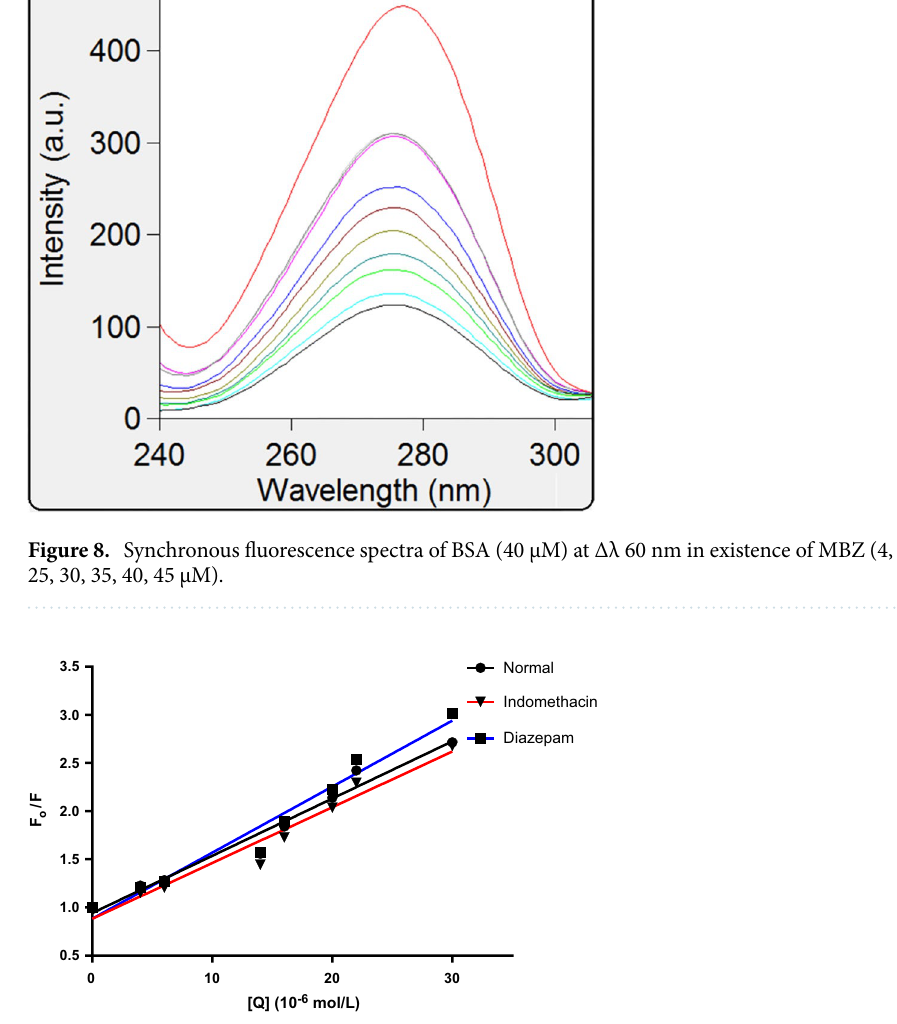
Figure 9. Stern–Volmer plots for BSA quenching by MBZ before and after adding site markers.